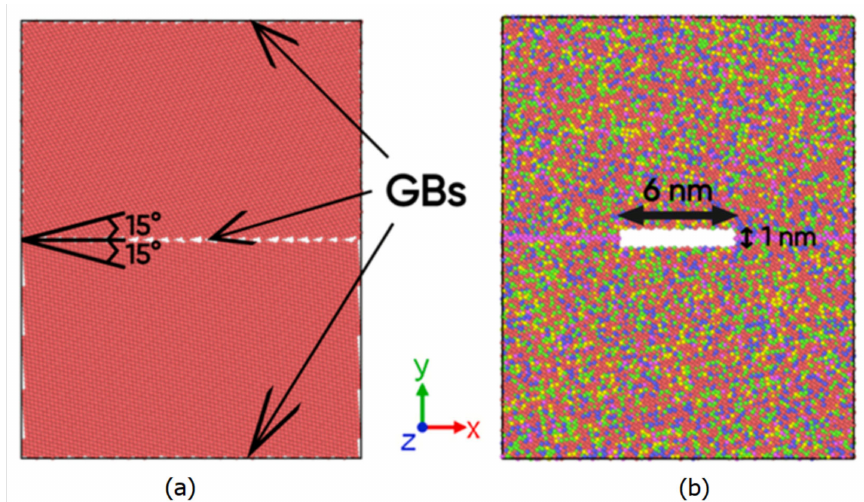
Figure 1. ( a ) The computational cell used for the simulations. ( b ) The bicrystal with the GB segrega- tion of copper (colored in purple) and a crack in the middle of the